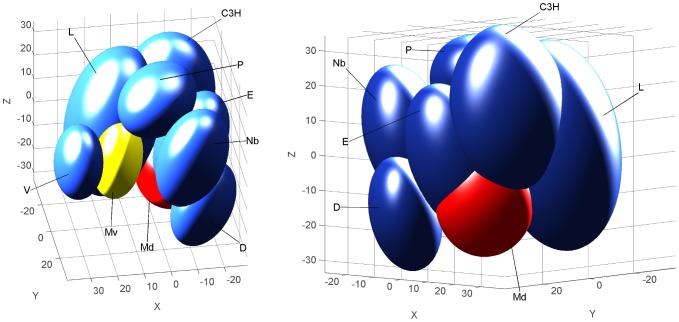
Human perception of the MV and MD mixtures.3D representations (2 different views) of the sensory map obtained from the free sorting task FS2 based on the sorting of two 6-component mixtures (MV and MD) and of their components (L, E, Nb, C3H, P, V and D) by human adults. The map was drawn using a non-metric MDS analysis. Ellipsoids represent 95% confidence intervals and were calculated using a bootstrap algorithm.